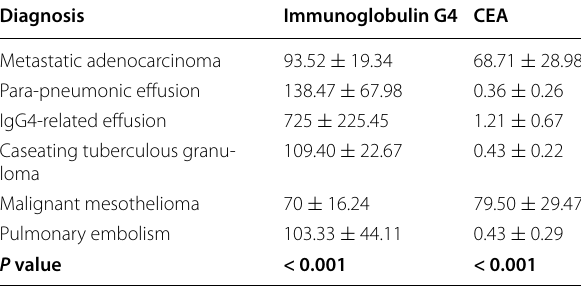
Table 6 The serum levels of immunoglobulin G‑4 and CEA based on the final diagnosis